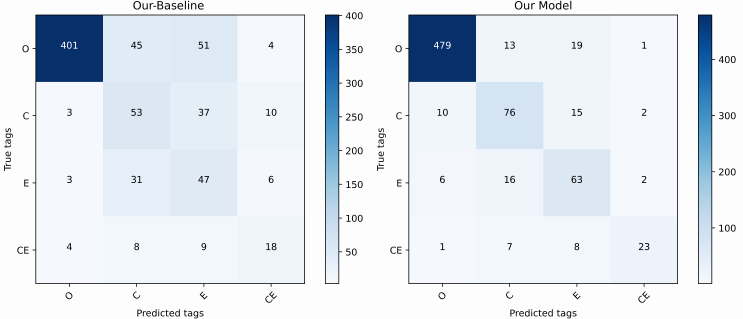
Figure 16. Contrasting models in testing label distributions for linked causality.